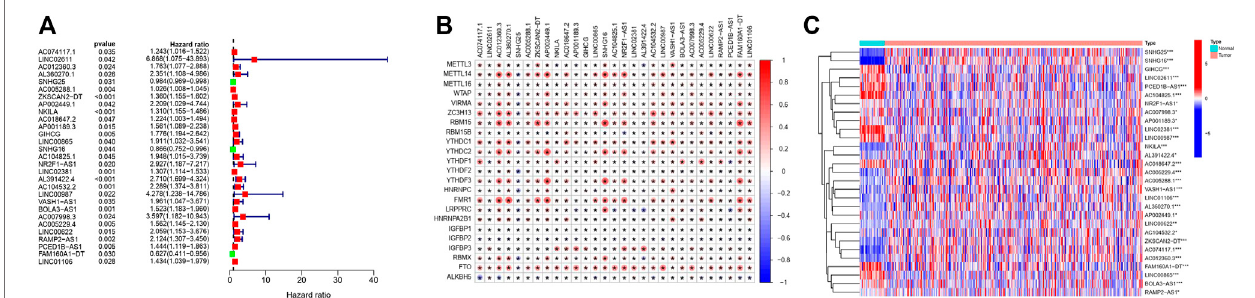
FIGURE 2 | Identi fi cation of prognostic m6A-related lncRNAs. (A) Forest plot of the results of univariate Cox PHR analysis, including the HR and p values of 29 m6A-related prognostic lncRNAs. (B) Heatmap of the correlations between m6A genes and the 29 prognostic m6A-related lncRNAs. The color represents the coef fi cient. p < 0.05(*). (C) Heatmapoftheexpressionlevelsofthe29m6A-relatedprognosticlncRNAsintheCOADsamplesandadjacentnormalsamples. p < 0.05(*), p < 0.01 (**), and p < 0.001 (***).